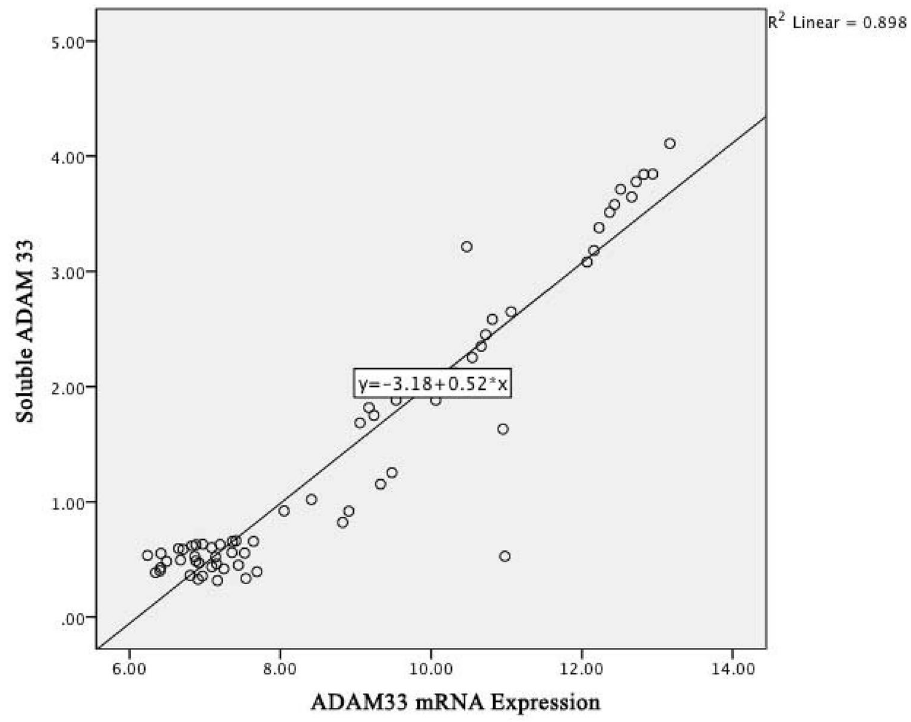
Figure 7. Linear regression graph between of ADAM33 mRNA expression and ADAM33 soluble levels in COPD